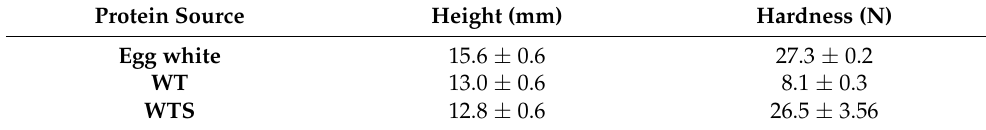
Table 6. Height and hardness of meringues produced with egg white, WT and WTS, n = 3; p > 0.05.